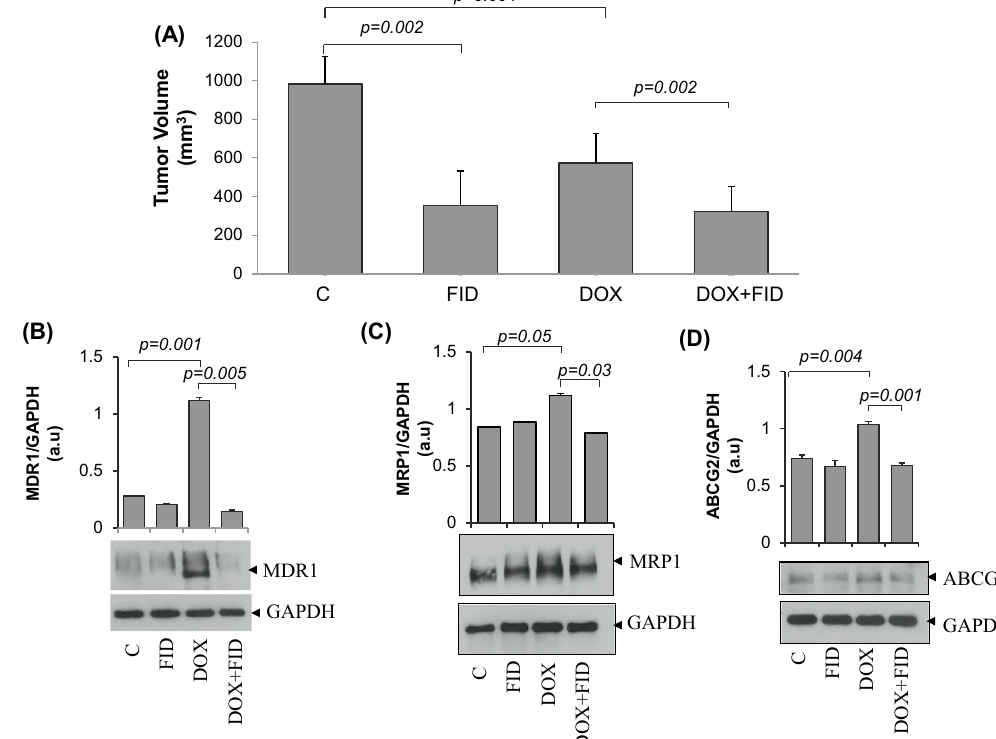
Figure 5. Effect of fidarestat in combination with doxorubicin in vivo : ( A ) Bars showing HT-29 xenograft tumor volume observed in nude mice after 21 days of treatment with DOX (4 mg kg − 1 wk − 1 i.p) alone or in combination with fidarestat in drinking water (25 mg kg − 1 ). (n = 6 in each group). Western blots showing expression of drug transporters ( B ) MDR1 ( C ) MRP1 and ( D ) ABCG2 in HT-29 xenograft tumor samples. The representative cropped blots are shown and the full-length blots are presented in Supplementary Fig. 6. Bars showing densitometry analysis by Image J software. Values are Mean ± SD. (n = 3) Individual p values are mentioned in the figures.